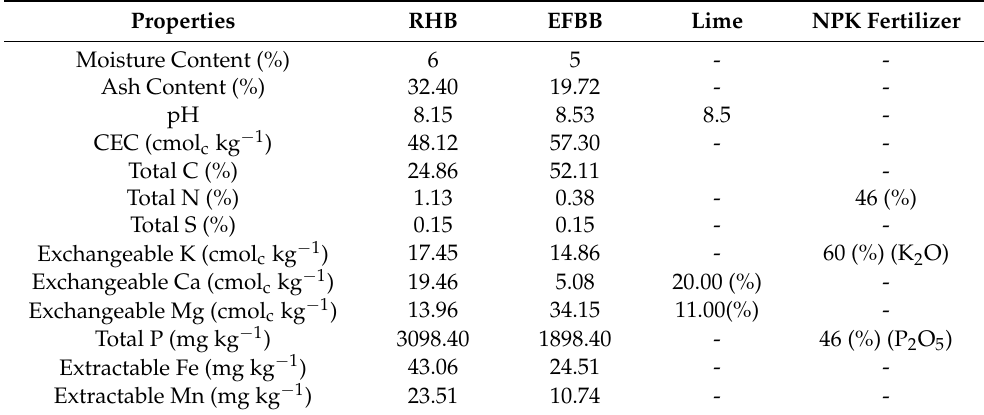
Table 2. Selected physical and chemical properties of RHB (rice husk), EFBB (empty fruit bunches), dolomitic limestone, and NPK